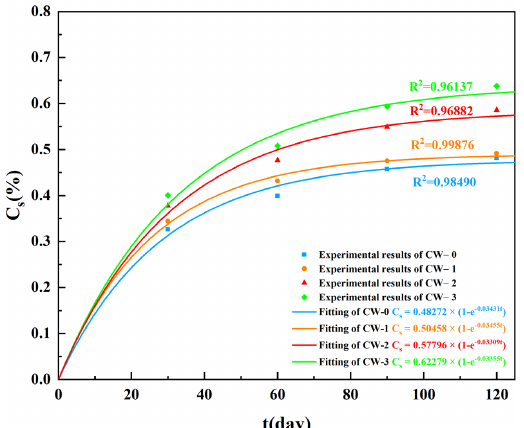
Figure 4. Influence of exposure time on surface chloride concentration.